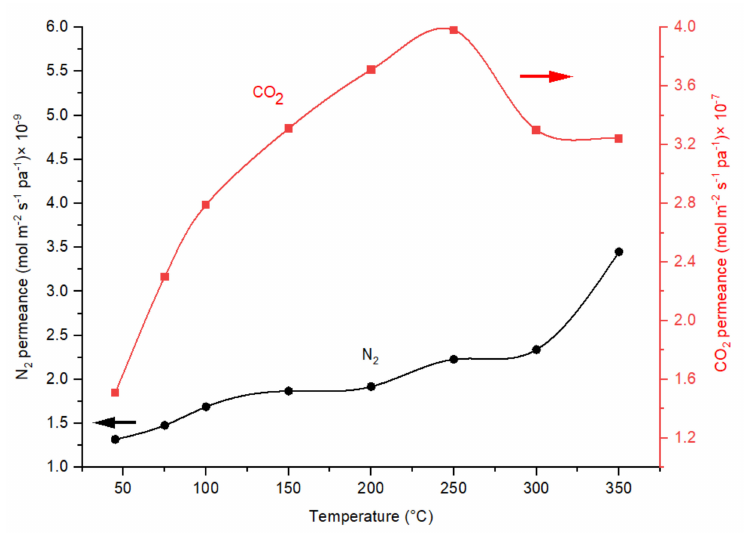
Figure 13. Effect of temperature on the CO 2 and N 2 permeances in CMSMs (Carbon Molecular Sieve Membrane) R80T150 in operational pressure of 6